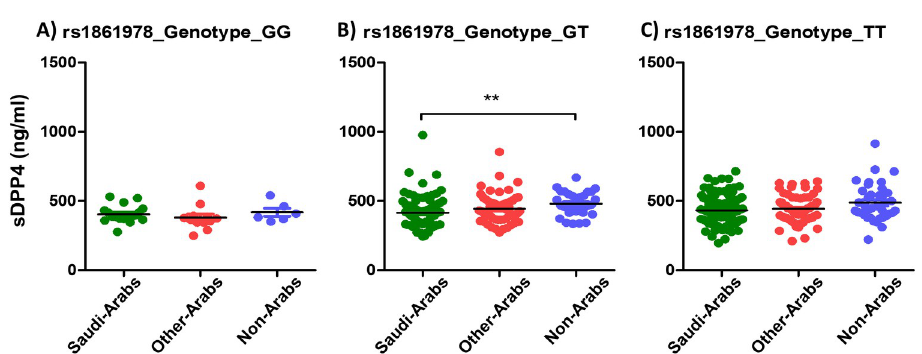
Fig 4. Average sDPP4 levels among different ethnic groups in relation to the rs1861978 genotypes.